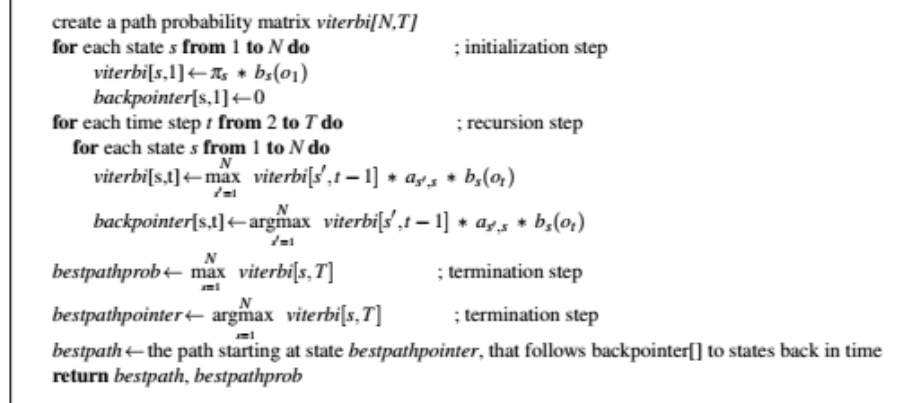
Figure 5. Viterby Algorithm.